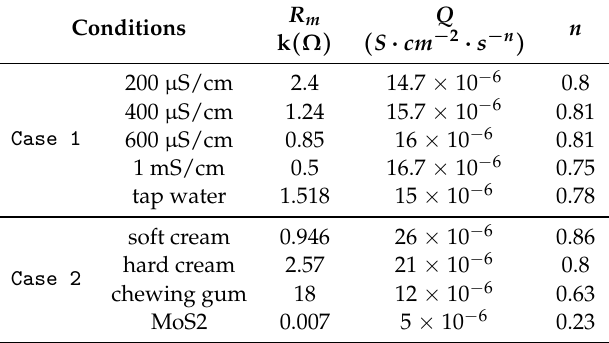
Table 3. Three parameters R m , Q and n for different cases. Case 1: no electrode fouled; Case 2: both electrodes